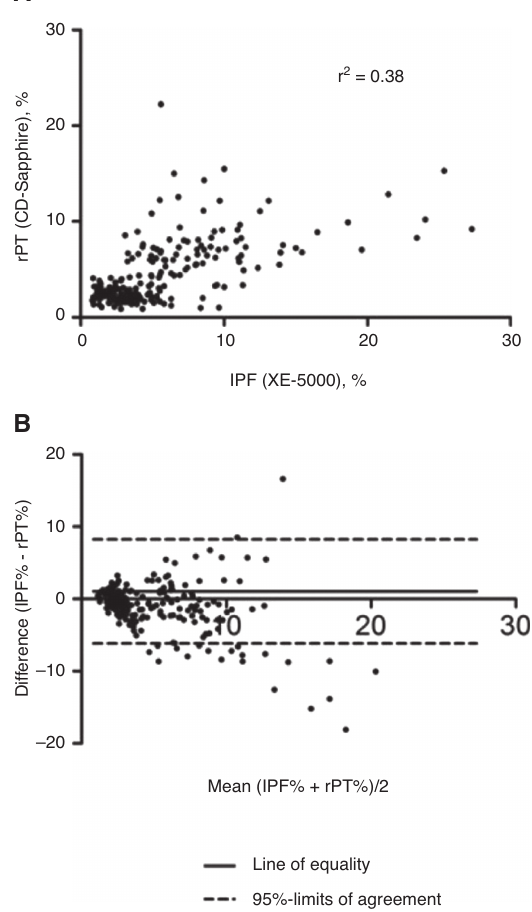
Figure 4: Comparison of IPF (Sysmex XE-5000) and retPLT (Abbott CELL-DYN Sapphire)